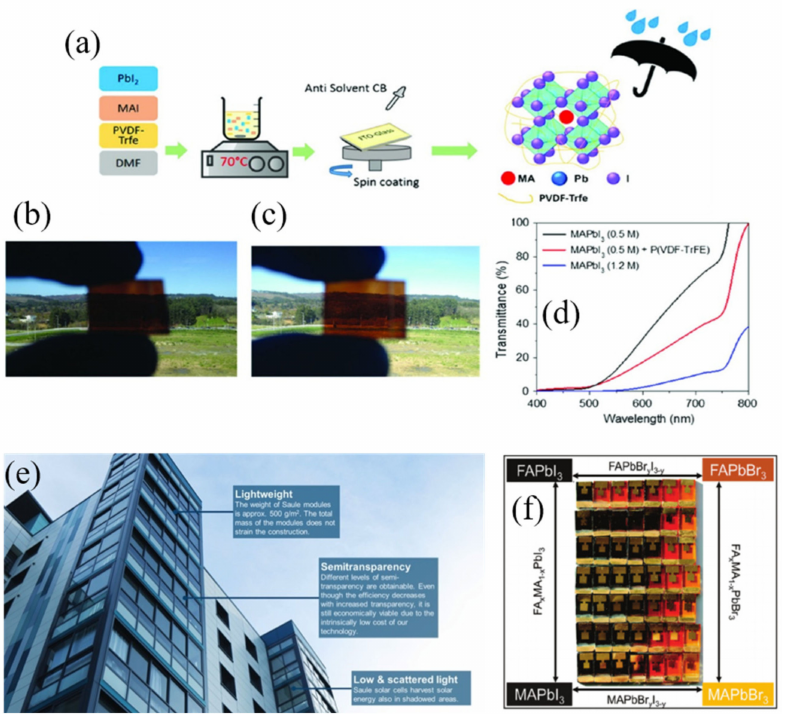
Figure 2. ( a ) Schematic representation of polymer addition in MAPbI 3 . Visual image of the perovskite layers with ( b ) routine concentration of 1.2 m ( ≈ 400nm perovskite thickness; ( c ) 0.5 m perovskite with P(VDF-TrFE) ( ≈ 150 nm perovskite thickness) showing semi-transparent effect and ( d ) transmittance spectra of two different concentrations of MAPbI 3 and with P(VDF-TrFE) [48]. ( e ) A pilot installation of perovskite solar cell in Spark office building’s façade in Warsaw (Reproduced with permission of [37] and ( f ) a photo of the fabricated cells, with different perovskite composition, showing the appearance in reflected light. Reproduced with permission of